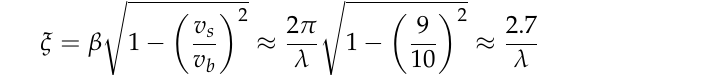
Figure 4. Substrate thickness versus frequency curve for different electrode materials.